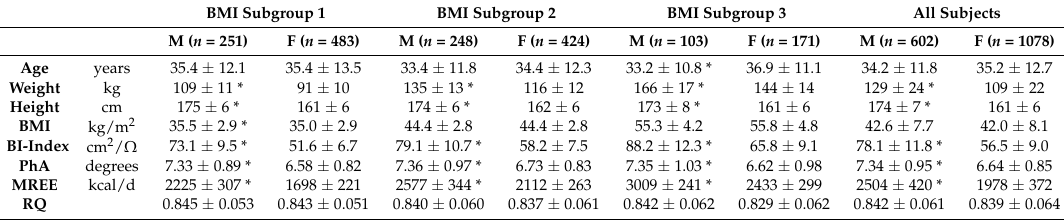
Table 1. Characteristics of BMI subgroups and the entire study sample for the calibration groups.